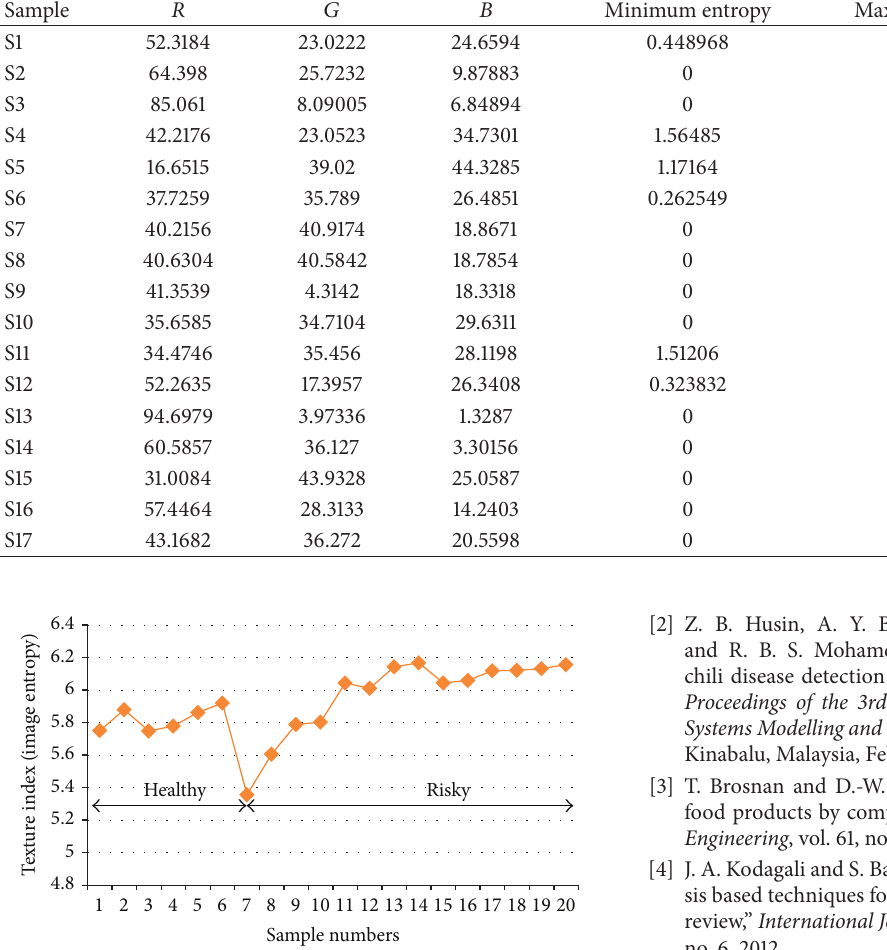
Figure 9: Tomato classification result (healthy and